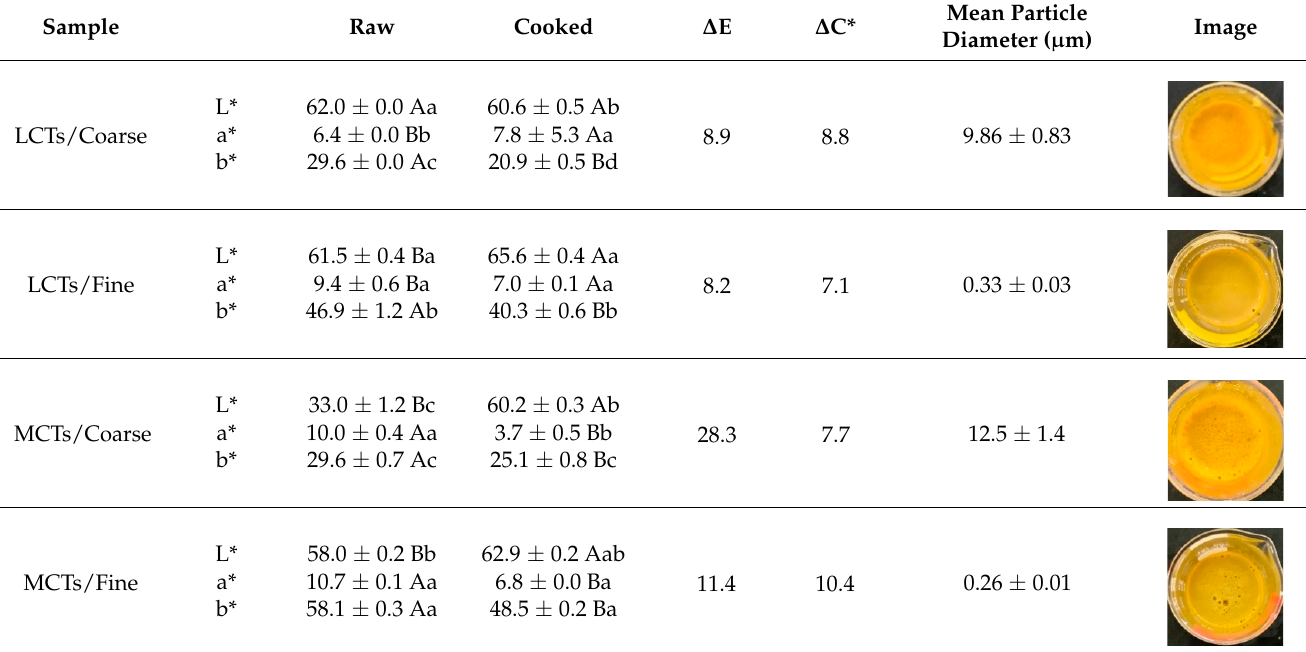
Table 1. Impact of droplet characteristics on the color coordinates of raw and cooked emulsions: L* (lightness/brightness), a* (redness/greenness), and b* (yellowness/blueness). Significant differences between raw and cooked samples are labeled by upper-case letters (A, B), whereas significant differences among oil types and droplet sizes are labeled by lower-case letters (a, b, c, d) with p < 0.05. The photographic images are for cooked samples. LCT: long chain triglycerides. MCT: medium chain triglycerides.